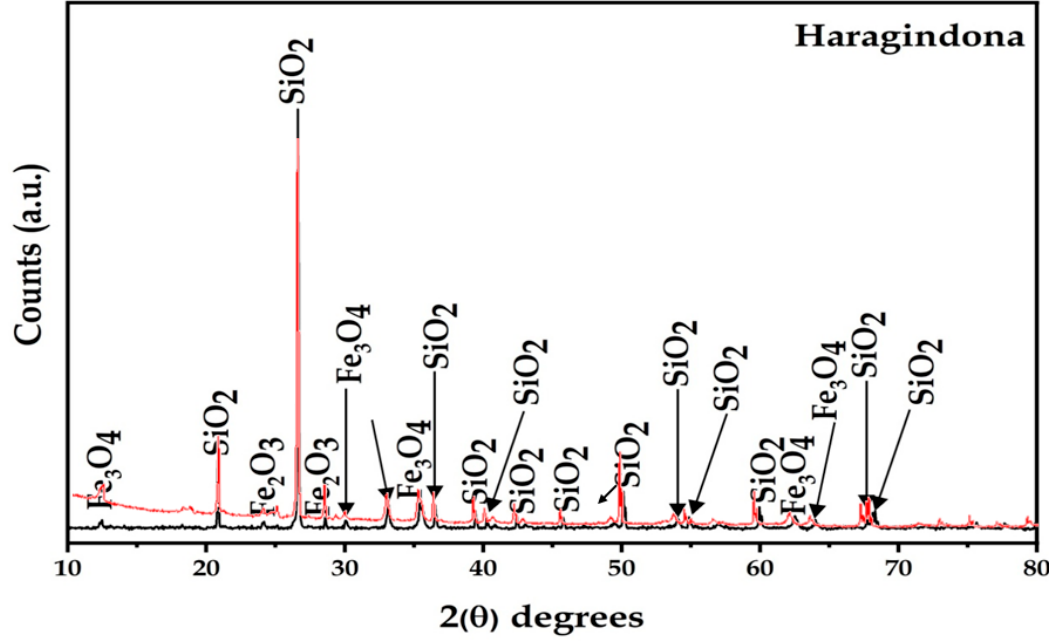
Figure 5. XRD plot of the BHQ sample.